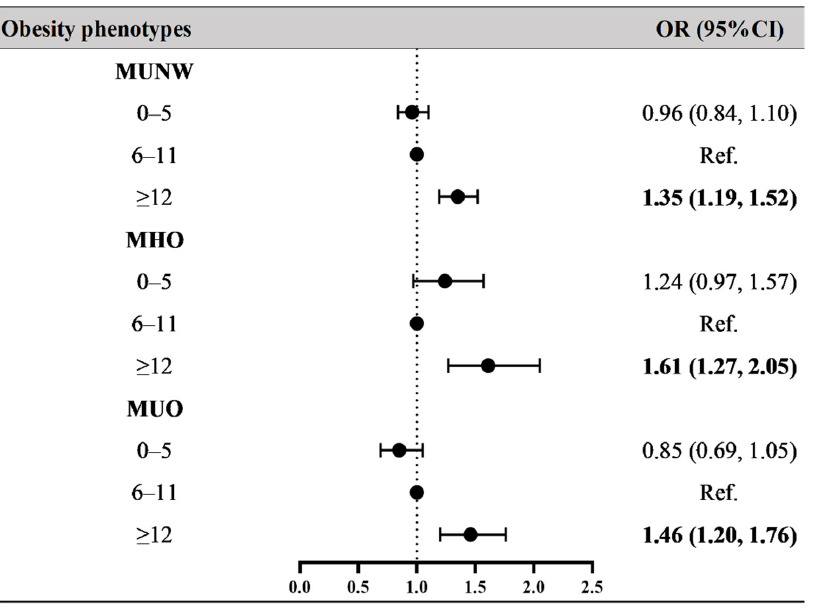
Figure 2. Associations between breastfeeding duration and obesity phenotypes. Obesity phenotypes include metabolic healthy normal weight (MHNW, reference group), metabolic unhealthy normal weight (MUNW), metabolic healthy obesity (MHO), and metabolic unhealthy obesity (MUO). Bold values of OR (95% CI) are statistically significant ( p < 0.05). Adjusted for age, sex, residence, single-child status, delivery model, delivery date, family history of diseases (obesity, hypertension, diabetes mellitus and cerebrovascular disease), parental education level, parental tobacco and alcohol consumption, maternal age at delivery, and family household income.